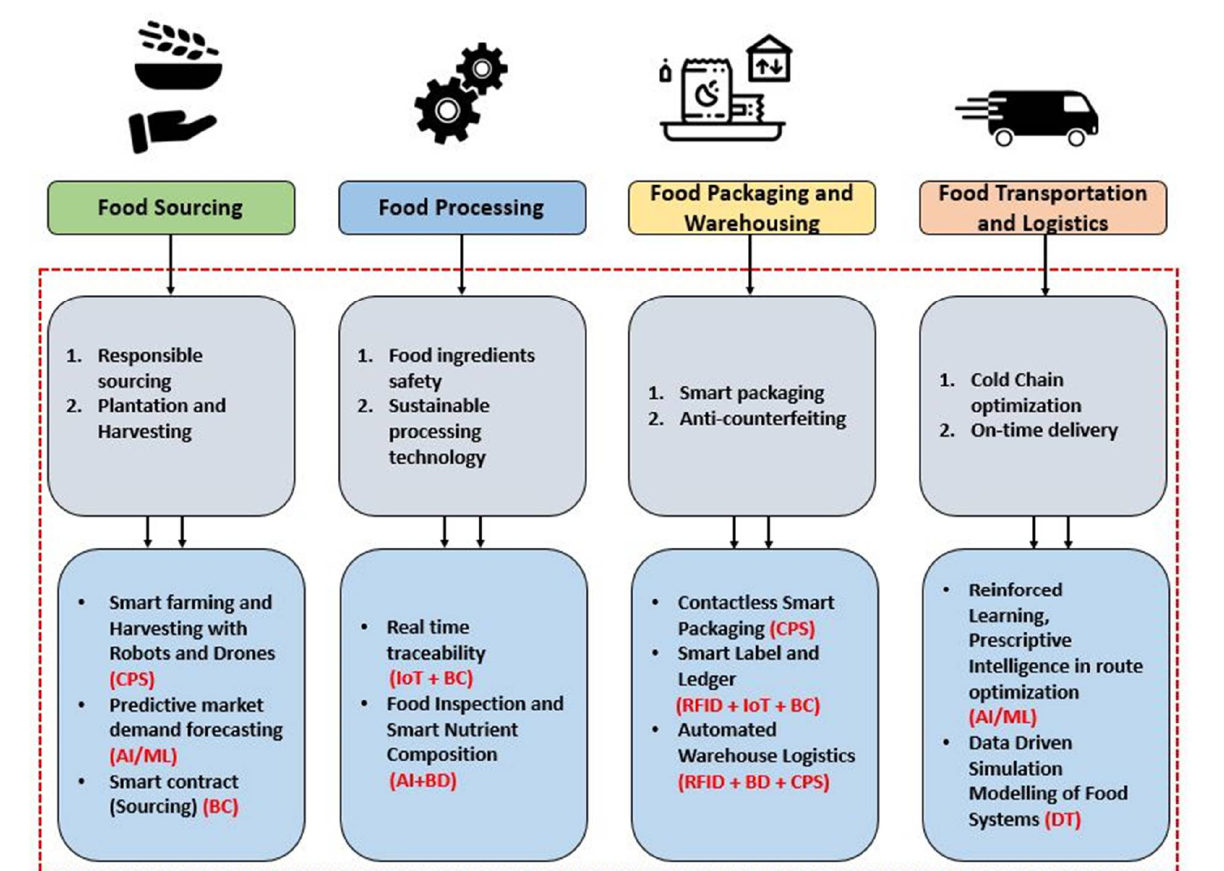
Figure 8. Food Supply Chain 4.0 Operational Paradigm.